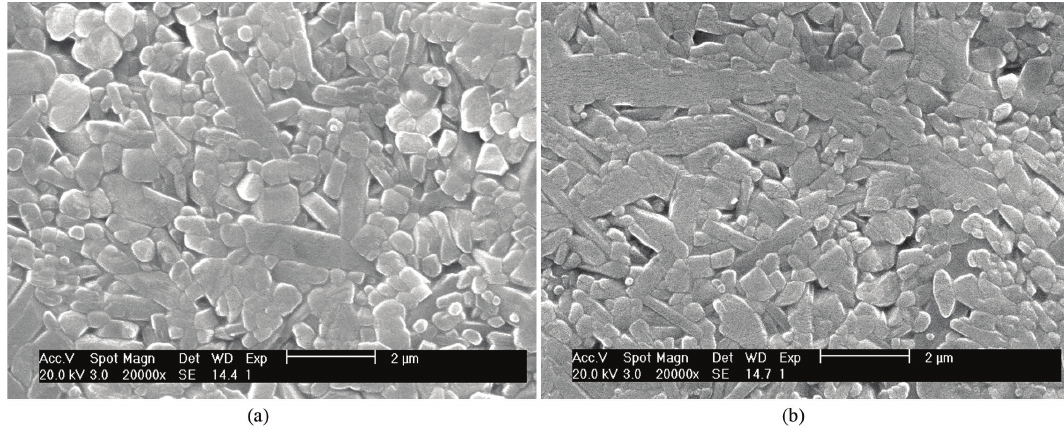
Figure 5. SEM micrographs of a) composition S sintered at 2.1kW for 35 min. b) composition A sintered at 2.1kW for 35 min. Table 2. Grain size distribution of samples sintered under different conditions for up to 40 min at 1.2, 1.8 and 2.1 kW. Composition